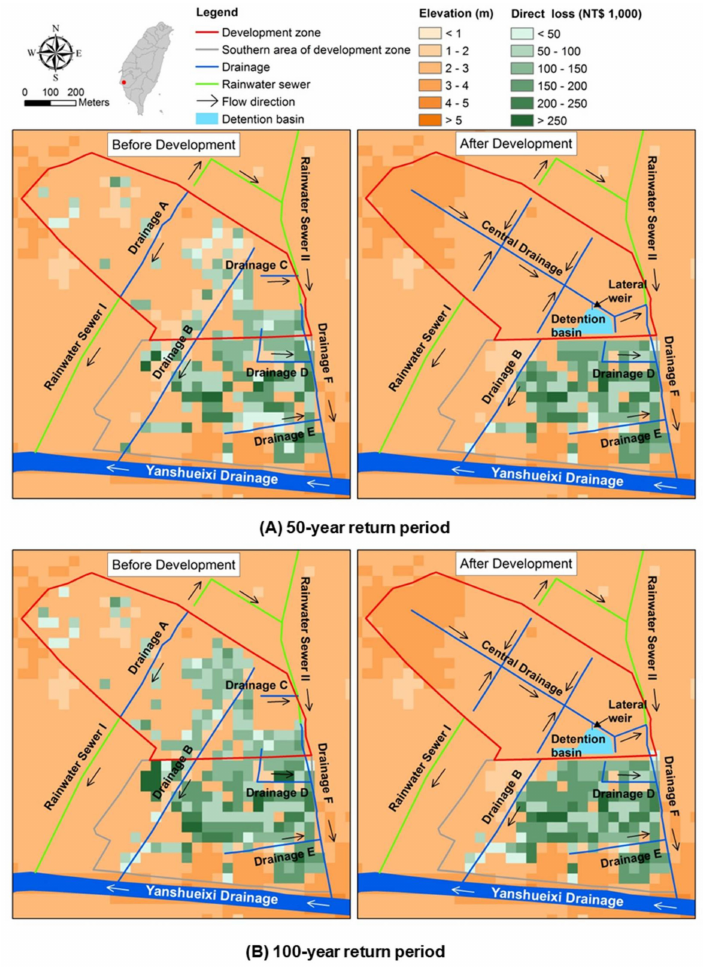
Figure 10. ( A ) The direct flood loss maps of 50-year return periods before and after land development. ( B ) The direct flood loss maps of 100-year return periods before and after land